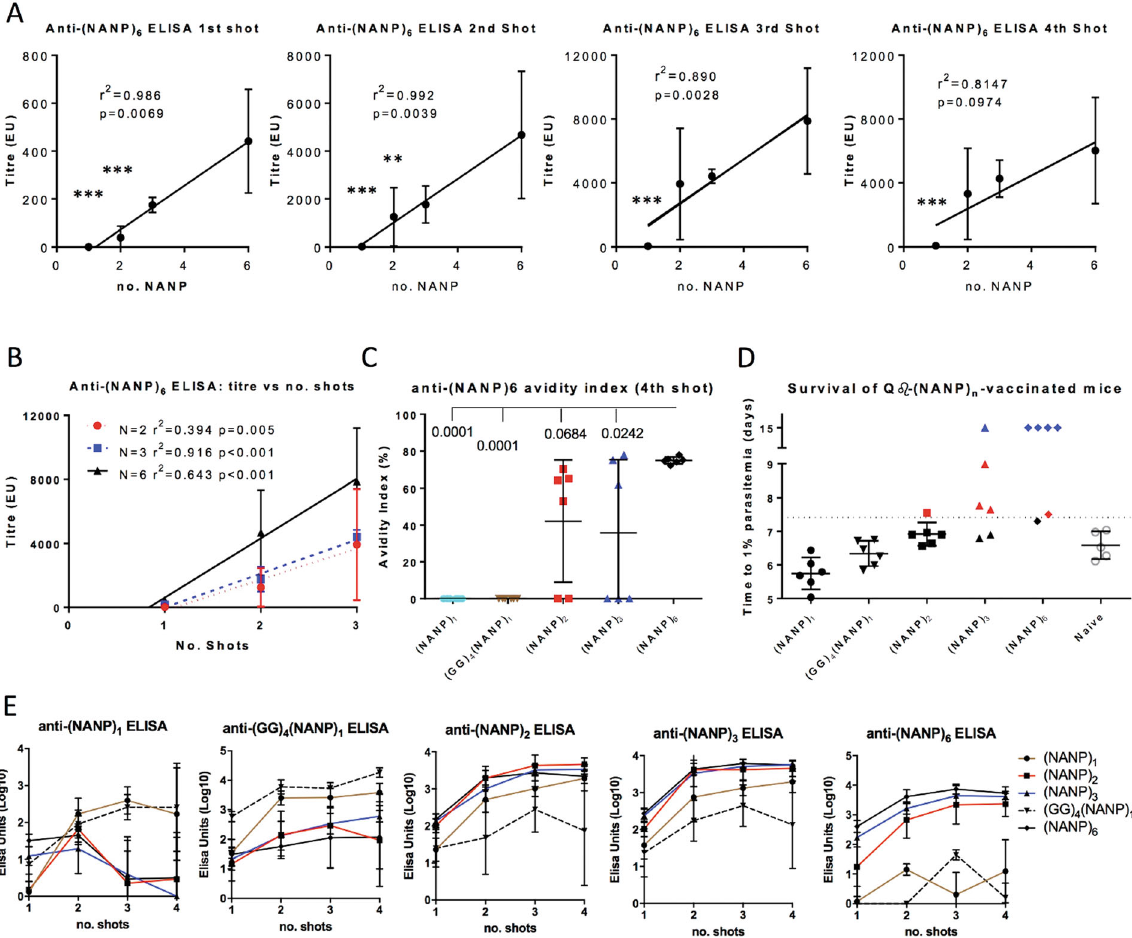
Fig. 4 Effects on immunogenicity and protective ef fi cacy of increasing the number of units repeats in Q β -(NANP) vaccines. Q β -(NANP) n VLPs were constructed by synthesising peptides with varying numbers of (NANP) unit repeats (no. NANP = 1, 2, 3, 6) and (GG) 4 (NANP) 1 and against (NANP) 6 . r 2 and p values from linear regressions are shown. Asterix represents signi fi cance levels of p < 0.01 (**) and p < 0.001 (***) by ANOVA in comparison to Q β -(NANP) 6 . B Titre versus a number of shots for each Qb-(NANP) n group, with N = 2, N = 3 or N = 6 as shown. C The 6 -vaccinated mice. D Three weeks after the fourth vaccination mice were challenged by intravenous injection of 1000 PfCSP transgenic P. berghei sporozoites. Thin blood smears were taken daily to determine the time to reach 1% blood-stage parasitaemia by linear regression. In ( A ) were also used to determine antibody titres speci fi c for each variable number of (NANP) repeats, 2 weeks post-vaccination; graph titles represent the peptide used to coat ELISA plates, and lines representing vaccination groups as shown. Means are shown ±